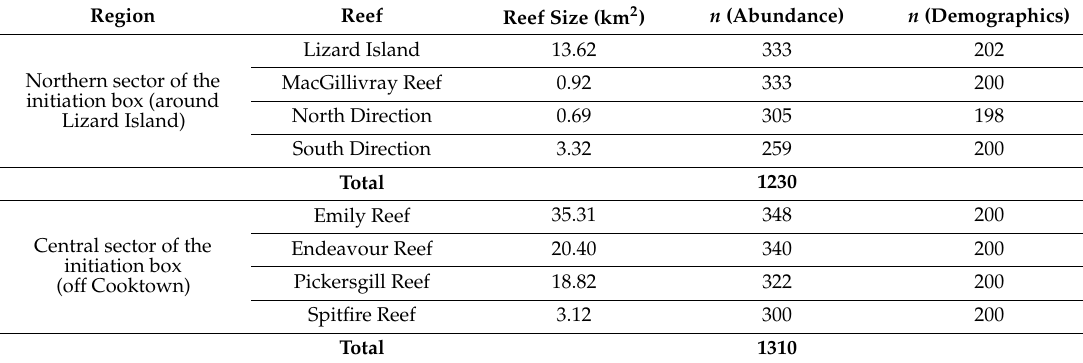
Central sector of the initiation box (off Cooktown)